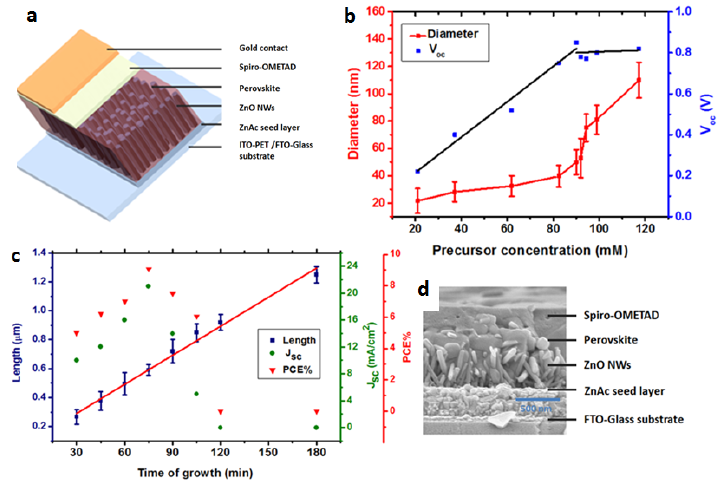
Figure 3. ( a ) The CH 3 NH 3 PbI 3 perovskite ZnO NWs solar cell structure; ( b ) The ZnO NWs length and the PV parameters as a function of the growth time at precursor concentration of 90 mM; ( c ) The change in the ZnO NWs diameter and the open circuit voltage (V oc ) as a function of the precursor concentration at 75 min growth time; ( d ) SEM cross section of the CH 3 NH 3 PbI 3 perovskite ZnO NWs perovskite solar cell.